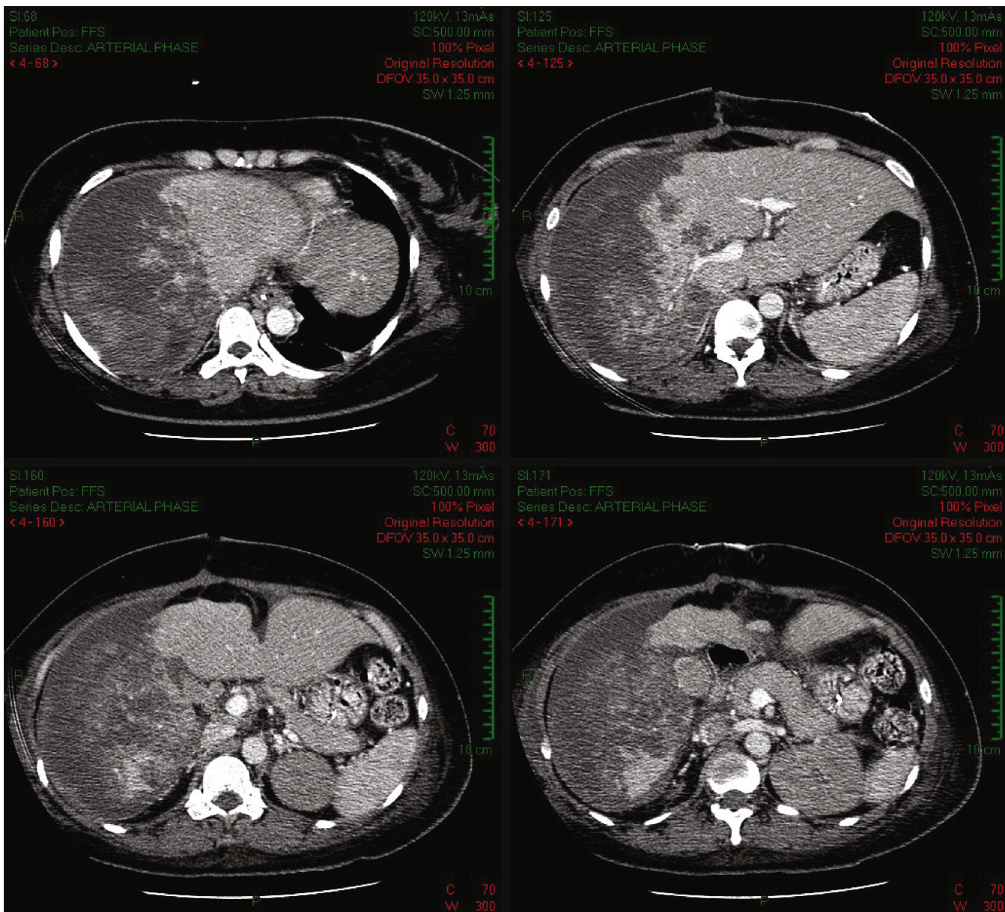
Figure 5: Perihepatic hematoma without signs of active bleeding on follow-up computed